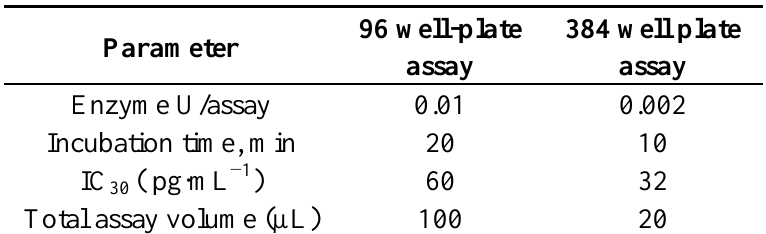
Table 4 . Miniaturization of assay volume and its effect on performance of the bi-enzyme reaction in 96 and 384 micro well plate formats. Inhibition parameters are compared for high throughput